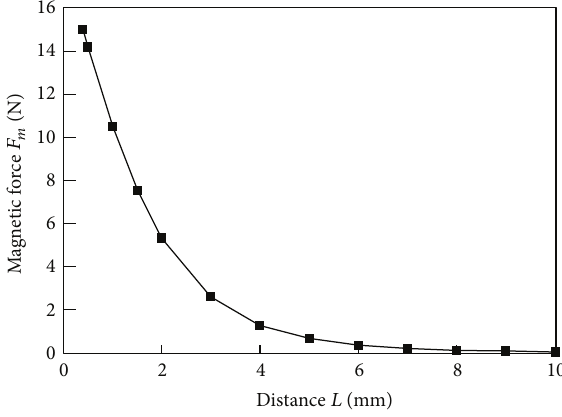
Figure 5: Dependence of magnetic force on distance.